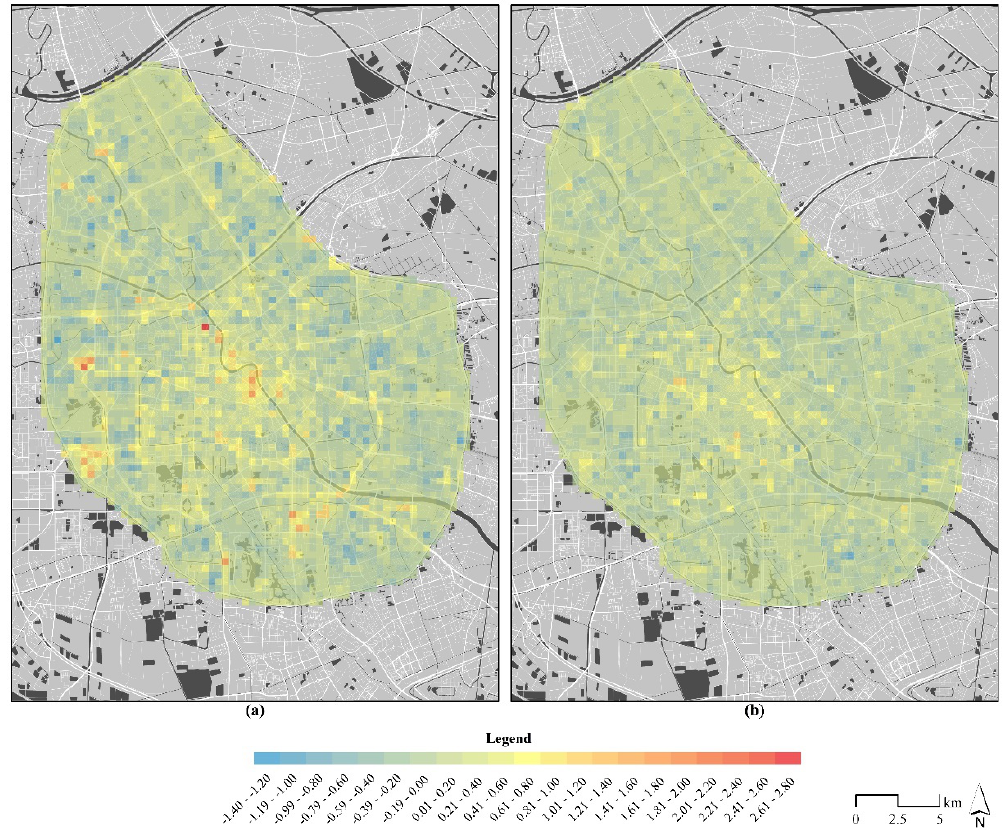
Figure 4. The population tidal index distribution during the pre-epidemic ( a ) and epidemic ( b ) periods.